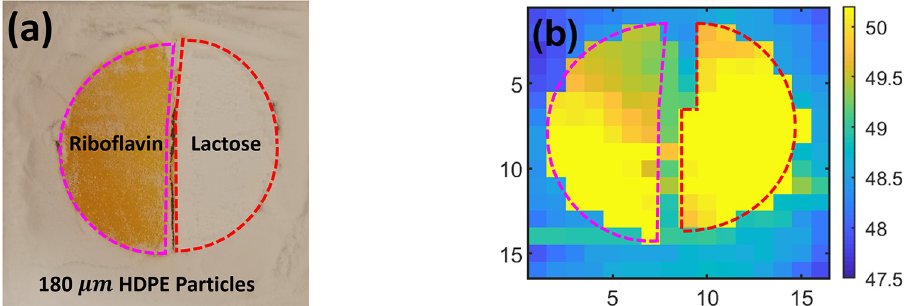
of the pellet at θ 0 is also shown with outlines for each pellet material.